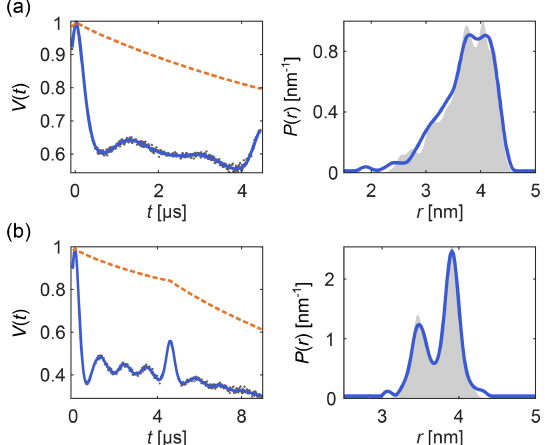
Figure 6. One-step analysis of multi-pulse DEER signals with the dipolar multi-pathway model for (a) four-pulse DEER with the “2 + 1 artifact” and (b) five-pulse DEER with its four-pulse “artifact”. All data were fit with two modulated dipolar pathways. The data are given as grey dots, the signal and distribution fits are given as solid blue lines, the background fit is given as an orange dashed line, and the ground truth is given as a shaded area.